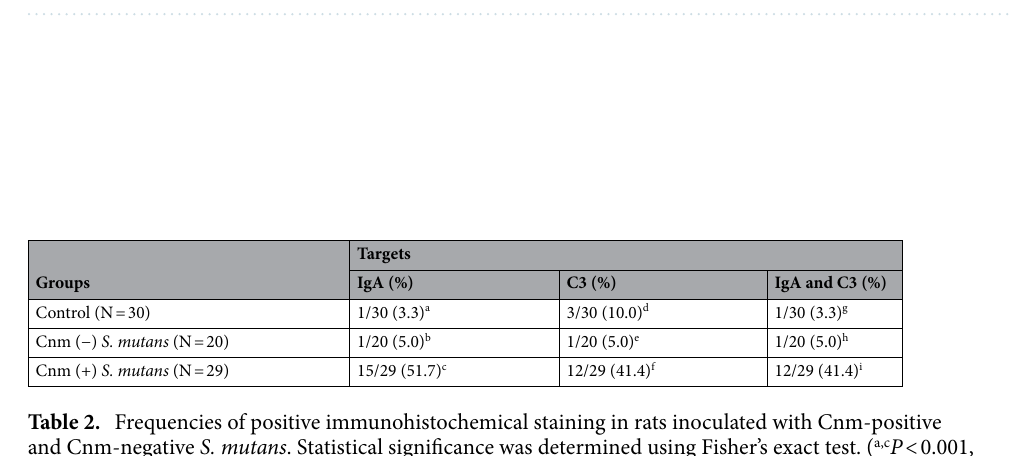
Figure 3. Representative histopathological appearance of kidney tissues by immunohistochemistry with a C3-specific antibody. The first image shows staining with an anti-C3 antibody. The second image shows staining with an anti-CD34 antibody. The third image shows nuclear staining. The fourth row of images is superpositions of the top three images.